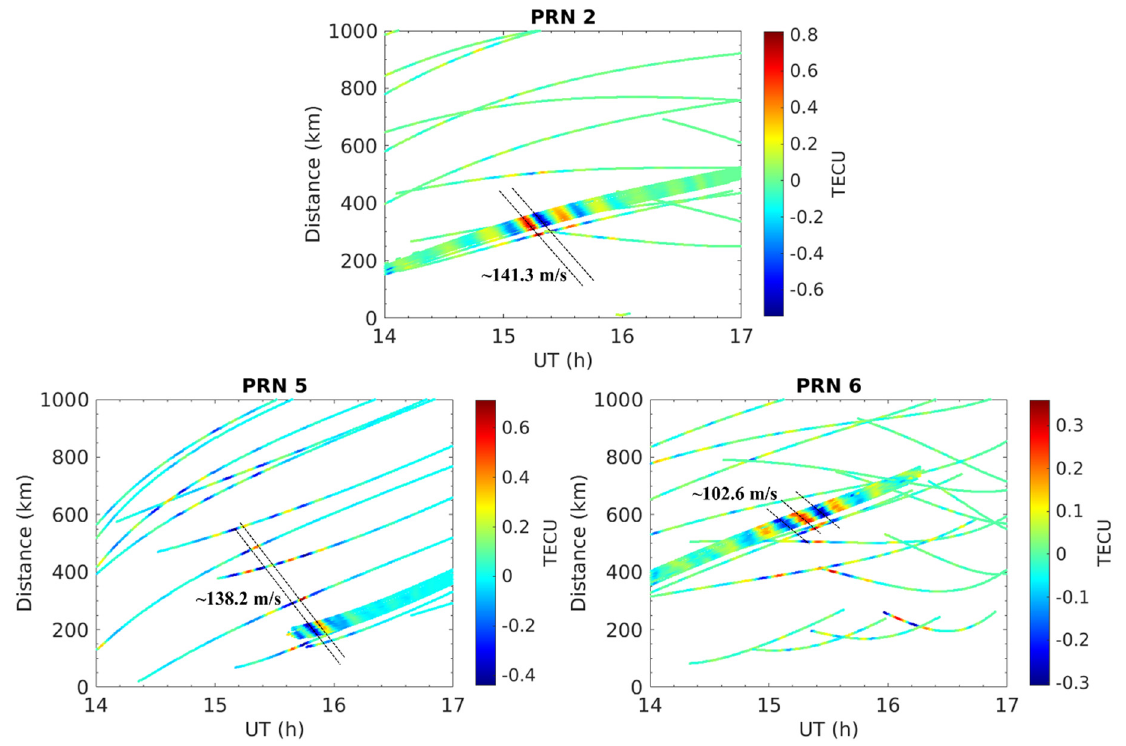
Figure 9. Determination of the propagation velocity of GWs. The horizontal coordinate indicates the UTC, the vertical coordinate indicates the distance of the IPP from the center of the thunderstorm, and the colorbar indicates the magnitude of the ionospheric disturbance.